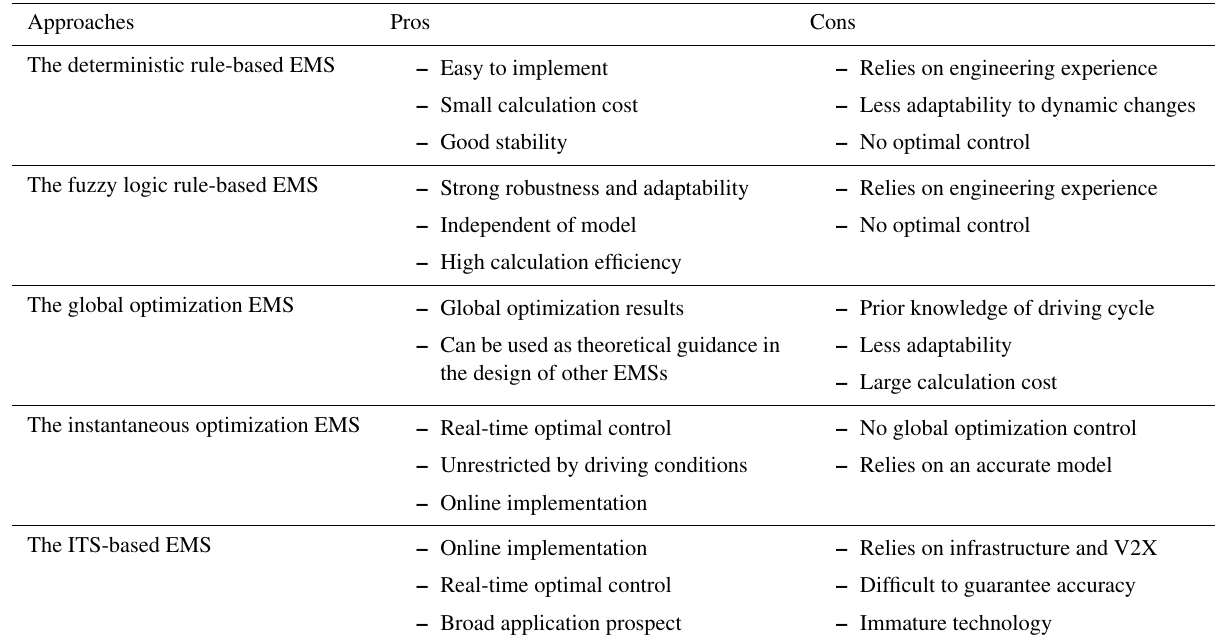
Table 17. The characteristics of different